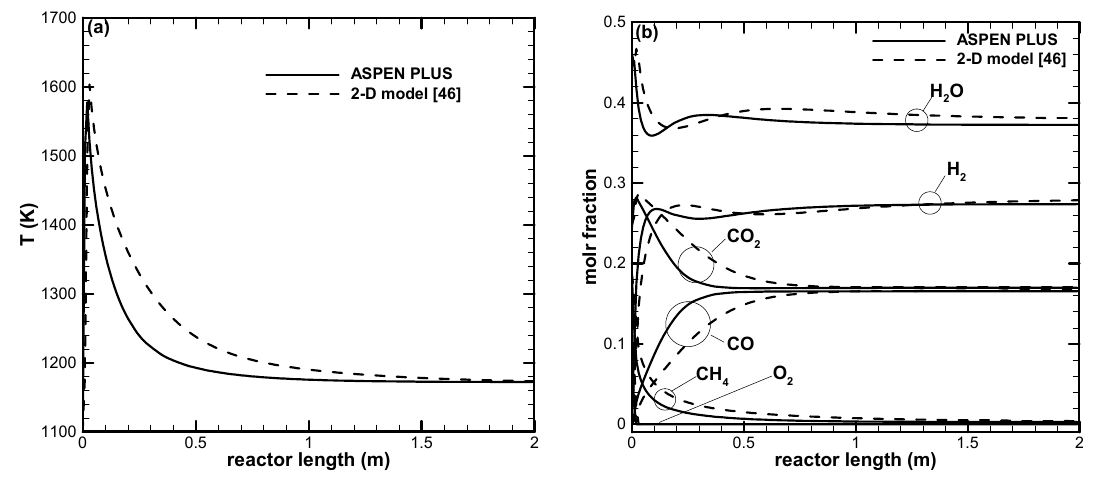
reactor length (m) Figure 2. Comparison of results predicted from Aspen Plus and two-dimensional model [46] using the optimized reactant composition reported by Arab Aboosadi et al. [47]. T in = 1100 K, p = 20 atm, and reactant composition CH 4 /CO 2 /H 2 O/O 2 = 1/1.3/2.46/0.47. ( a ) Temperature and ( b ) species mole fraction variations along the reactor center line.